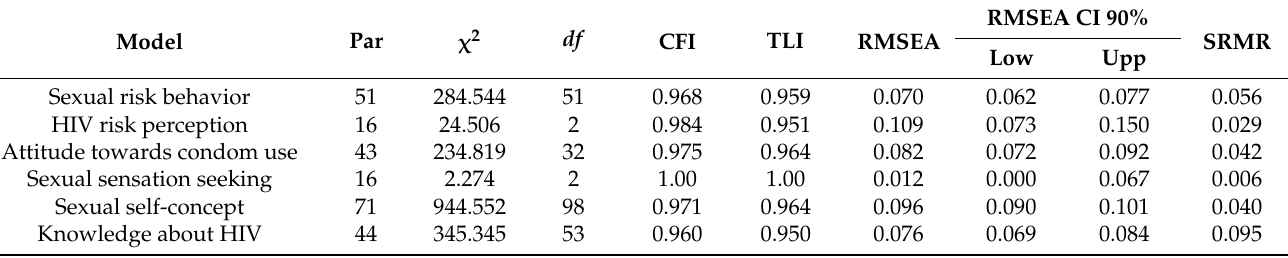
Table 2. Global fit of measurements models.